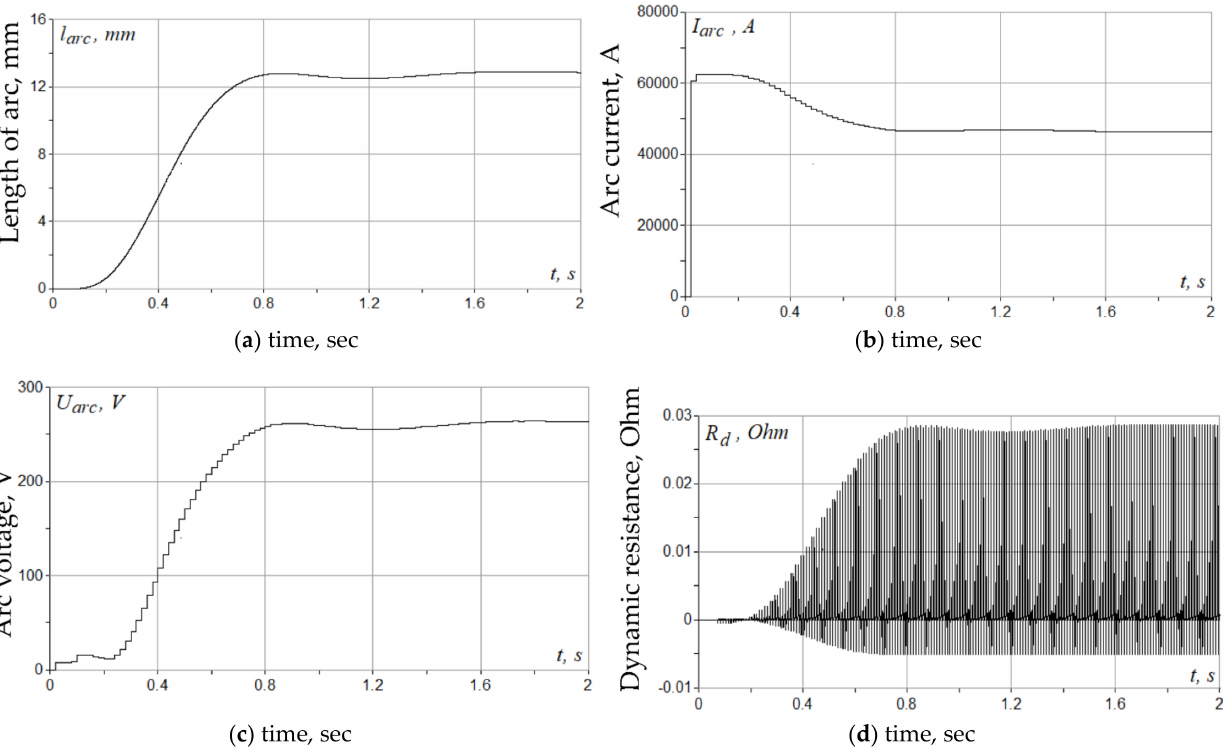
Figure 14. Arc length ( a ), current value of arc current ( b ), current value of arc voltage ( c ), dynamic arc resistance ( d ) in transient electrode movement